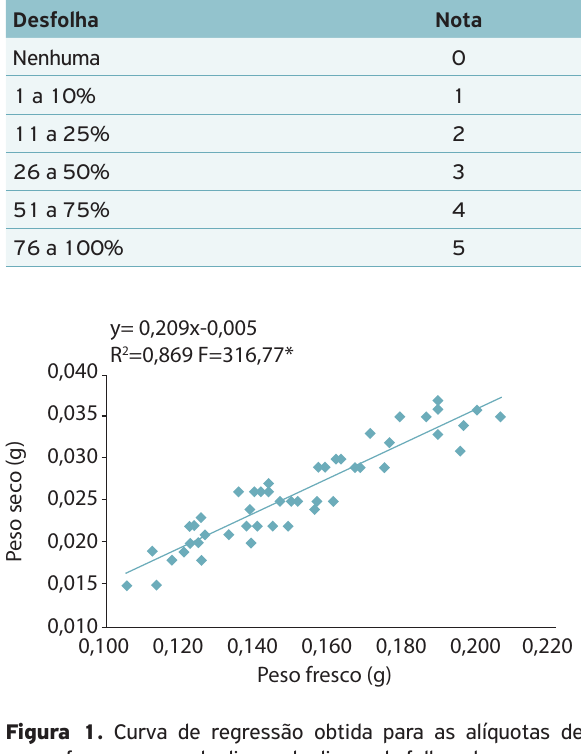
Tabela 1. Escala visual estabelecida para atribuição de notas